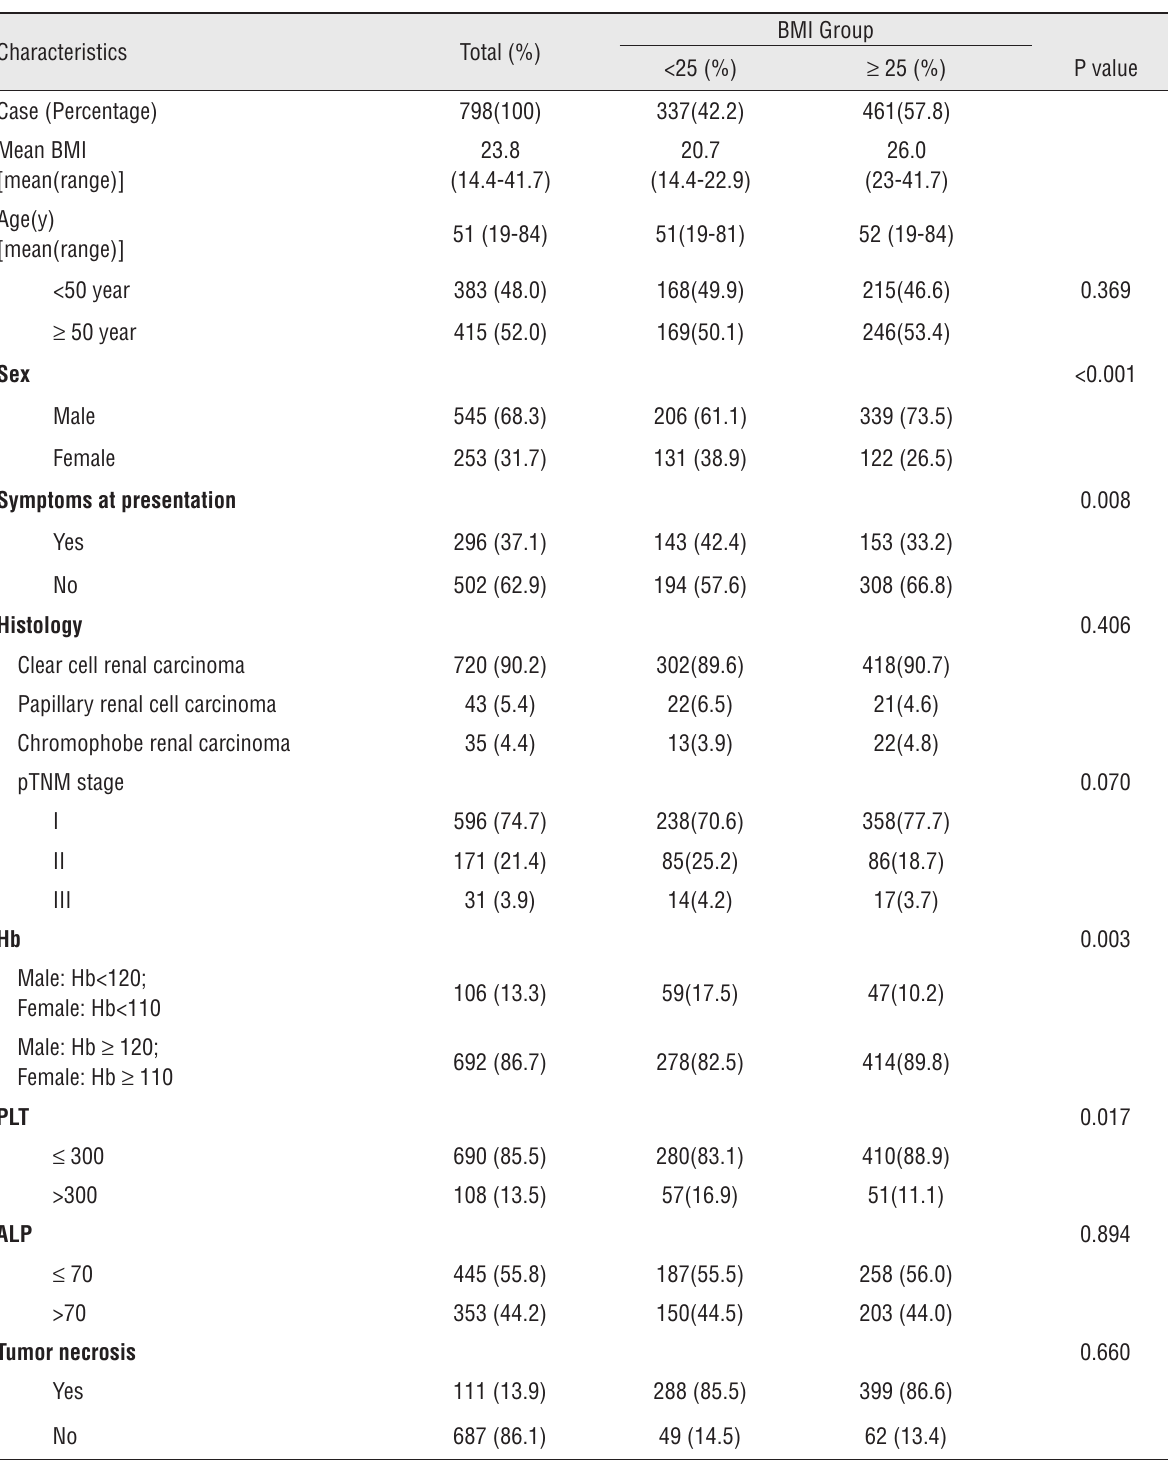
Table 1 - Baseline Characteristics by BMI